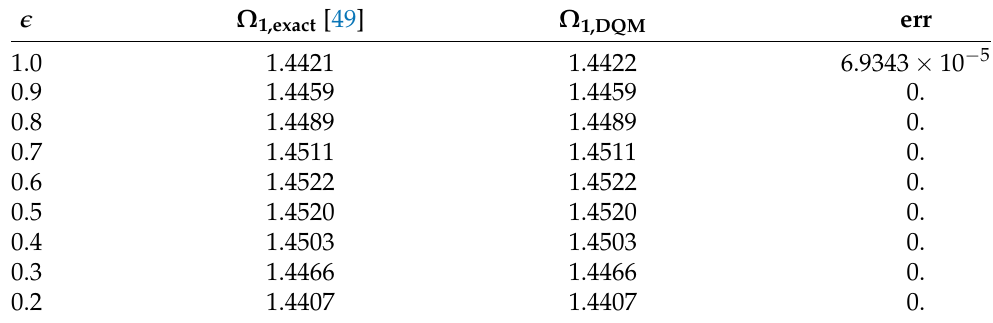
Table 3. Comparison of the first dimensionless frequency Ω 1 from the exact solution [49] and DQM for different (cid:101) . The other parameters are q 1 = 2, q 2 = 2, η = 0, λ = 0.5, K R = 0, and K T =